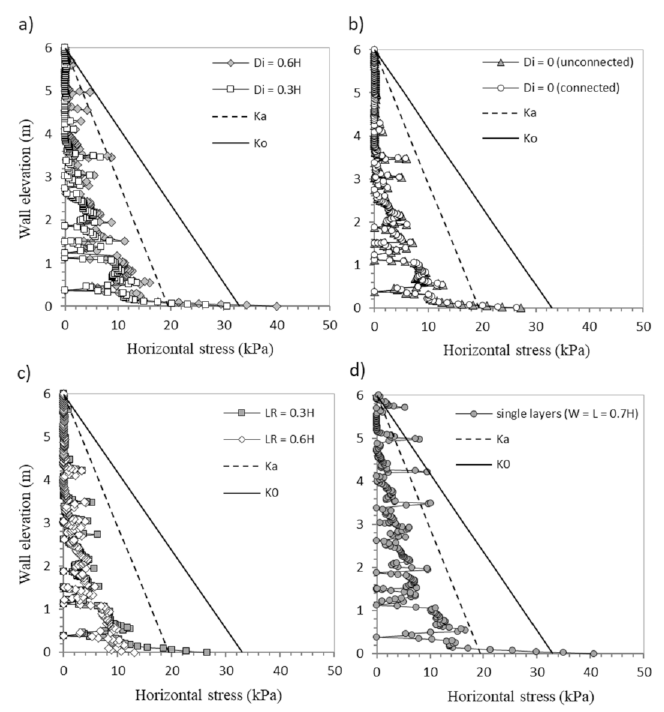
Figure 12. Lateral earth pressure at the facing at the end of construction (EoC) for different interaction distances ( D i ) between back-to-back reinforced soil walls: ( a ) D i > 0, ( b ) D i = 0, and ( c , d ) D i < 0.